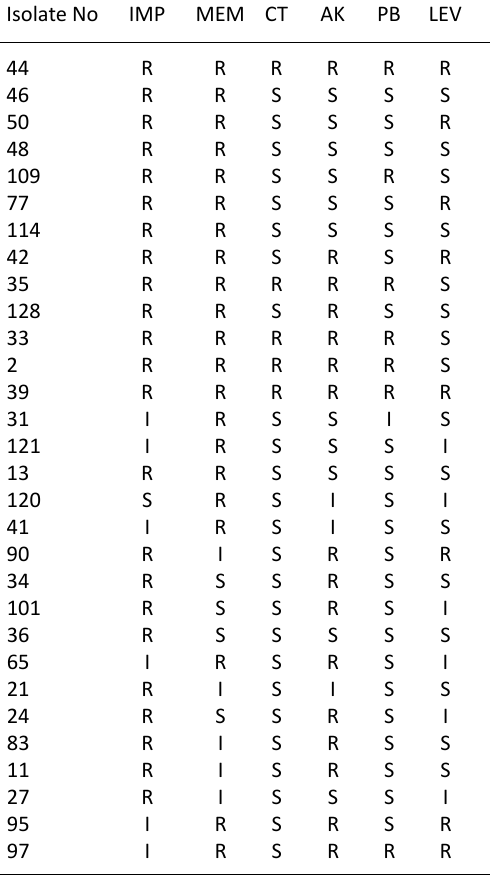
Table 1. Susceptibility of selected antimicrobials against carpabenems-resistant Gram negative isolates collected in this study. IMP: Imipenem, MEM: Meropenem ,CT: Colistin, AK: Amikacin, PB: Polymyxin and LEV: Levofloxacin. The antibiotic susceptibility testing was according to Kirby Bauer disk diffusion